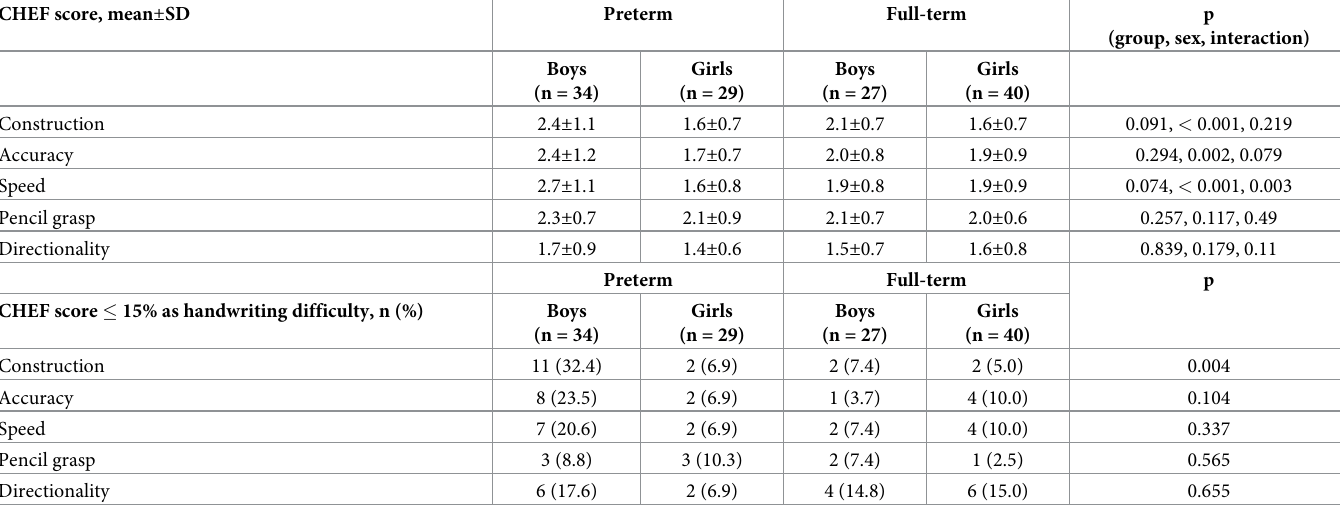
Table 2. Handwriting performance of preterm and full-term children in grade two. CHEF score, mean ±